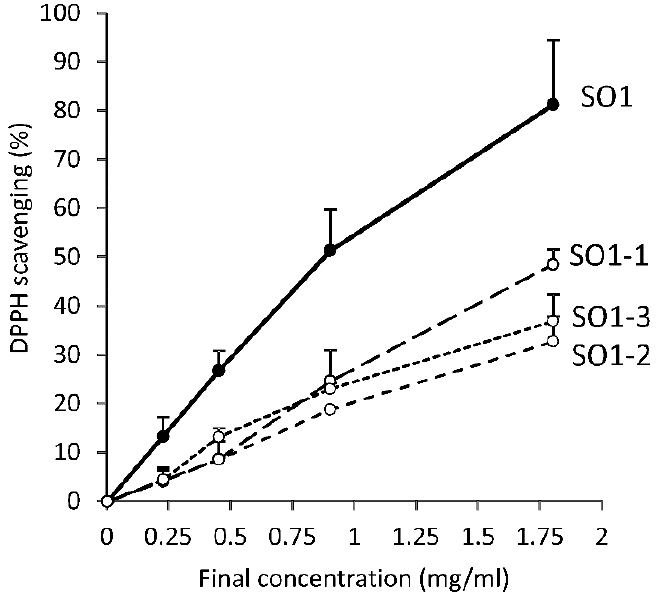
Figure 8. The DPPH radical scavenging activity of SO1 and of its components obtained by separation on DEAE-cellulose column. Data are presented as the mean ± SD of three independent experi- ments.